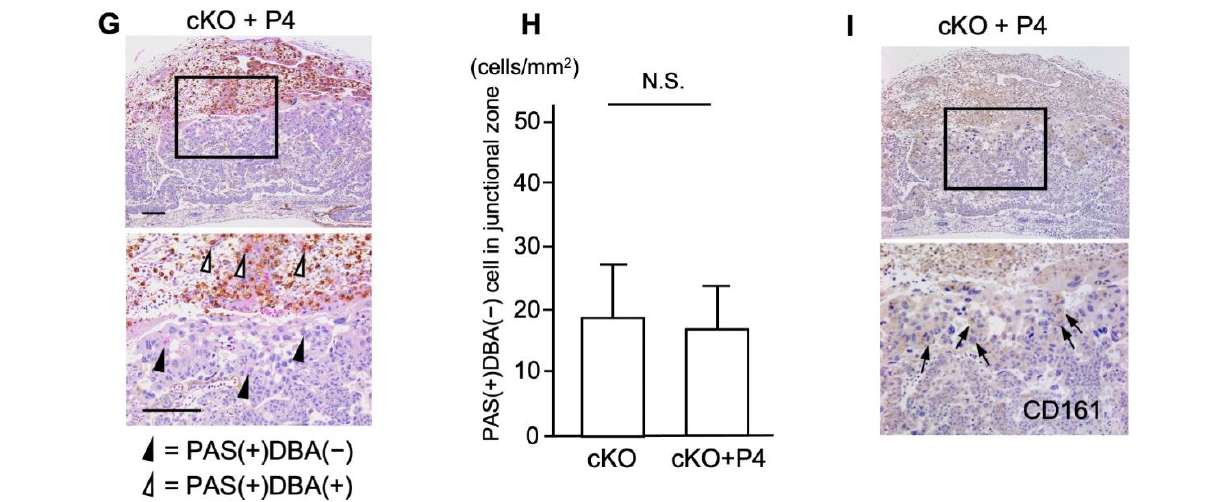
Figure 5. P4 supplement rescues pregnancy failure in cKO mice. ( A ) Serum P4 levels in WT and cKO on days 8 and 12 of pregnancy. The mean P4 levels in the control group (WT, n = 5) and in the cKO groups with normal implantation (w/IS, n = 2) and with confirmed inhalation (w/o IS, n = 4) on day 8 of pregnancy, and those in the control group (WT, n = 4), the cKO groups with implantation (w/IS, n = 4) and without implantation (w/o IS, n = 6), and the progesterone-treated cKO group (w/P4, n = 5) on day 12 of pregnancy. The bar shows STDEV. Differences between groups were analyzed by the unpaired t -test. *, p < 0.01; **, p < 0.05. ( B , C ) Representative of the uterus of WT and cKO with P4 supplementation on days 8 ( B ) and 12 ( C ) of pregnancy. ( D , E ) Representative of HE-stained uterus of WT and cKO with P4 supplementation on days 8 ( D ) and 12 ( E ). ( F ) The percentage of maternal blood vessels, which contain denucleated red blood cells (RBC). The bar shows SE. Differences in the ratio of calculated areas of maternal vessels between the WT and cKO mice were analyzed by the unpaired t -test. ( G ) DBA/PAS double staining of the placenta from cKO with P4 supplementation on day 12 of pregnancy. Black arrowheads show PAS-positive and DBA-negative cells. White arrowheads show both PAS- and DBA-positive cells. ( H ) Numbers of DBA-positive and -negative uNK cells were not significantly different between cKO and cKO witn P4 supplementation. ( I ) CD161 staining of the placenta from cKO with P4 supplementation on day 12 of pregnancy. Arrows show CD161 positive cells in the spongiotrophoblast layers. The scale bar shows 100 µ m. N.S., not significant.